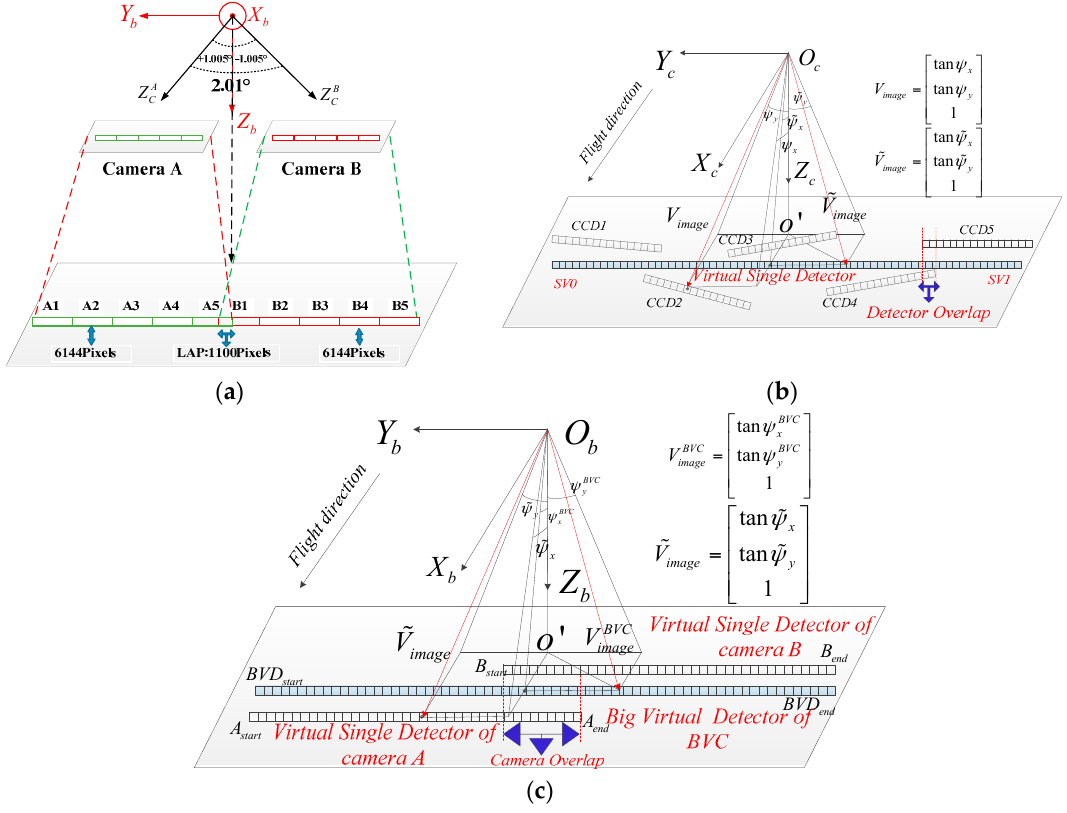
Figure 1. ( a ) The installation structure and configuration of the GF2 double-camera imaging system; ( b ) Schematic diagram of the virtual single detector in the single camera; ( c ) Schematic diagram of the big virtual detector in the big virtual camera.